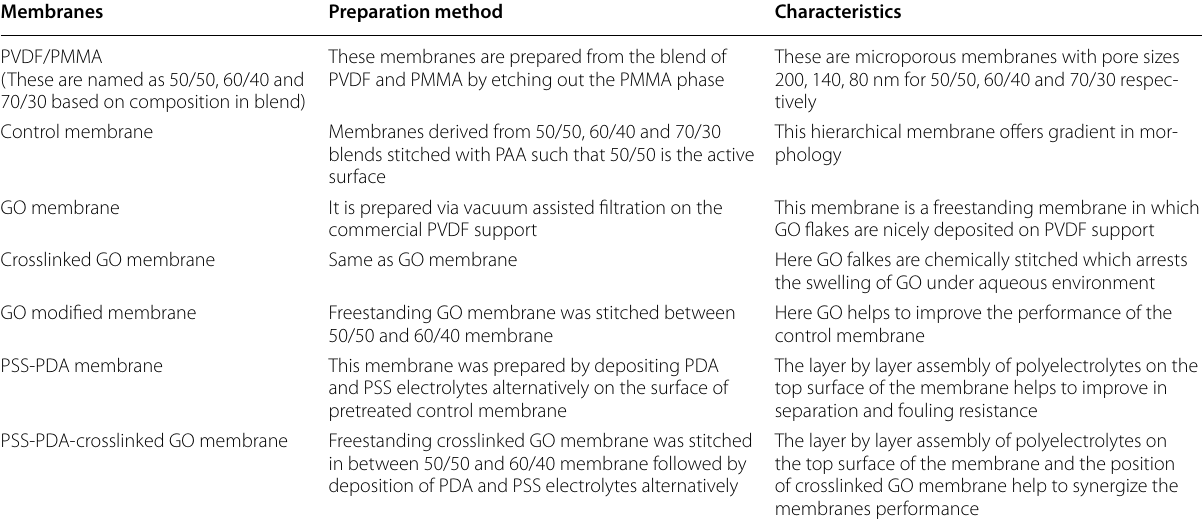
Table 1 Brief description about all the prepared membranes Membranes Preparation